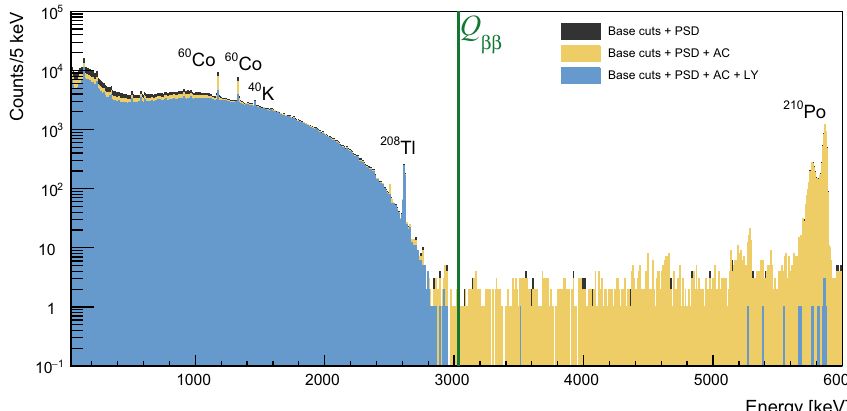
Fig. 8 Unblinded spectrum of physics data in CUPID-Mo with suc- cessive application of cuts. The application of the PSD cuts produces a spectra containing all events with good pulse-shape characteristics. Applicationoftheanti-coincident(AC)cutremovesalleventswithmul- tiplicity greater than one, along with any possible delayed coincidences